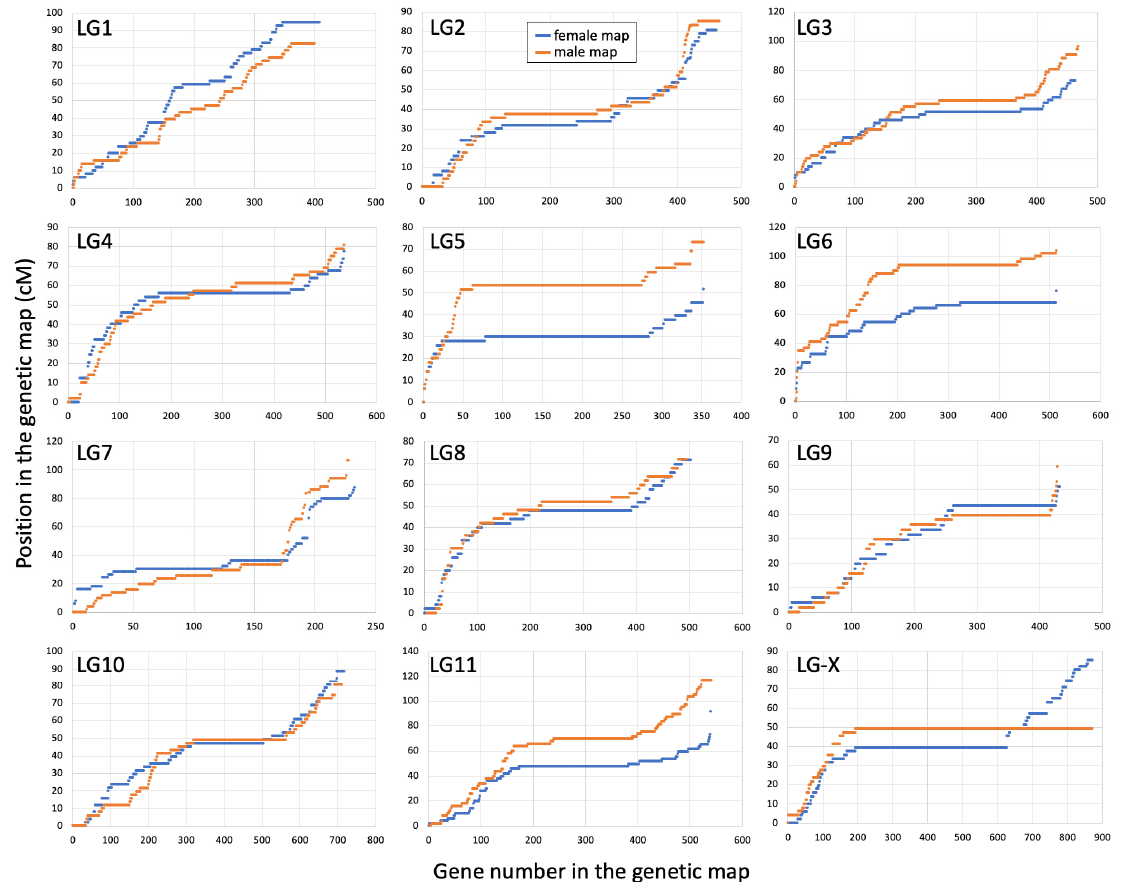
Figure 2. Cumulative genetic distance for 12 linkage groups (LG) in the female (blue) and male (orange) genetic maps.